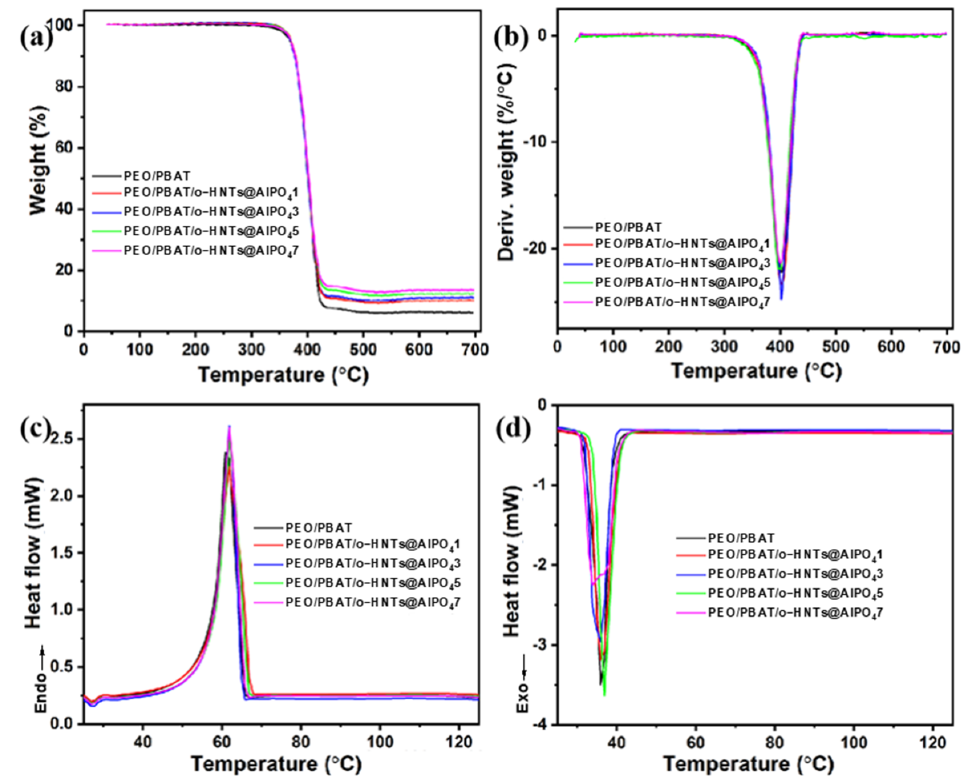
Figure 4. ( a ) The TG, ( b ) DTG, and ( c , d ) DSC curves of the PEO/PBAT and PEO/PBAT/o- HNTs@AlPO 4 films, where ( c , d ) represent the heating and cooling processes, respectively. Table 3. Data of the TG and DSC of the PEO/PBAT/o-HNTs@AlPO 4 films.